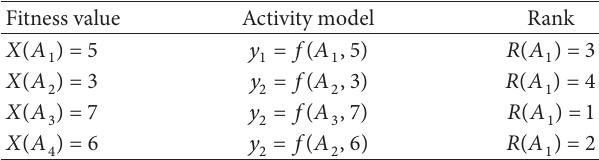
Table 2: Activity ranking in the